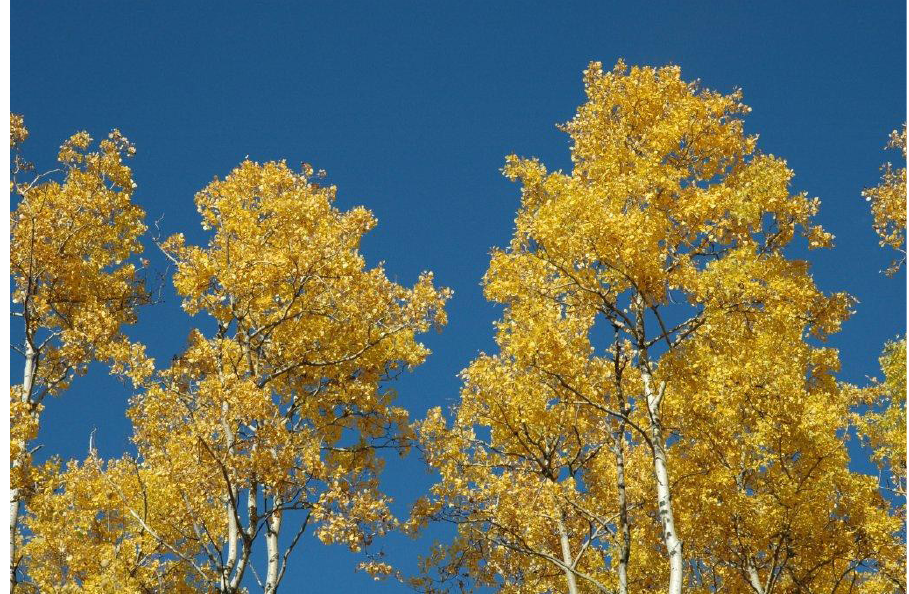
Figure 1 . Photovoice image (Image Otto F. Mahler, 2010, used with